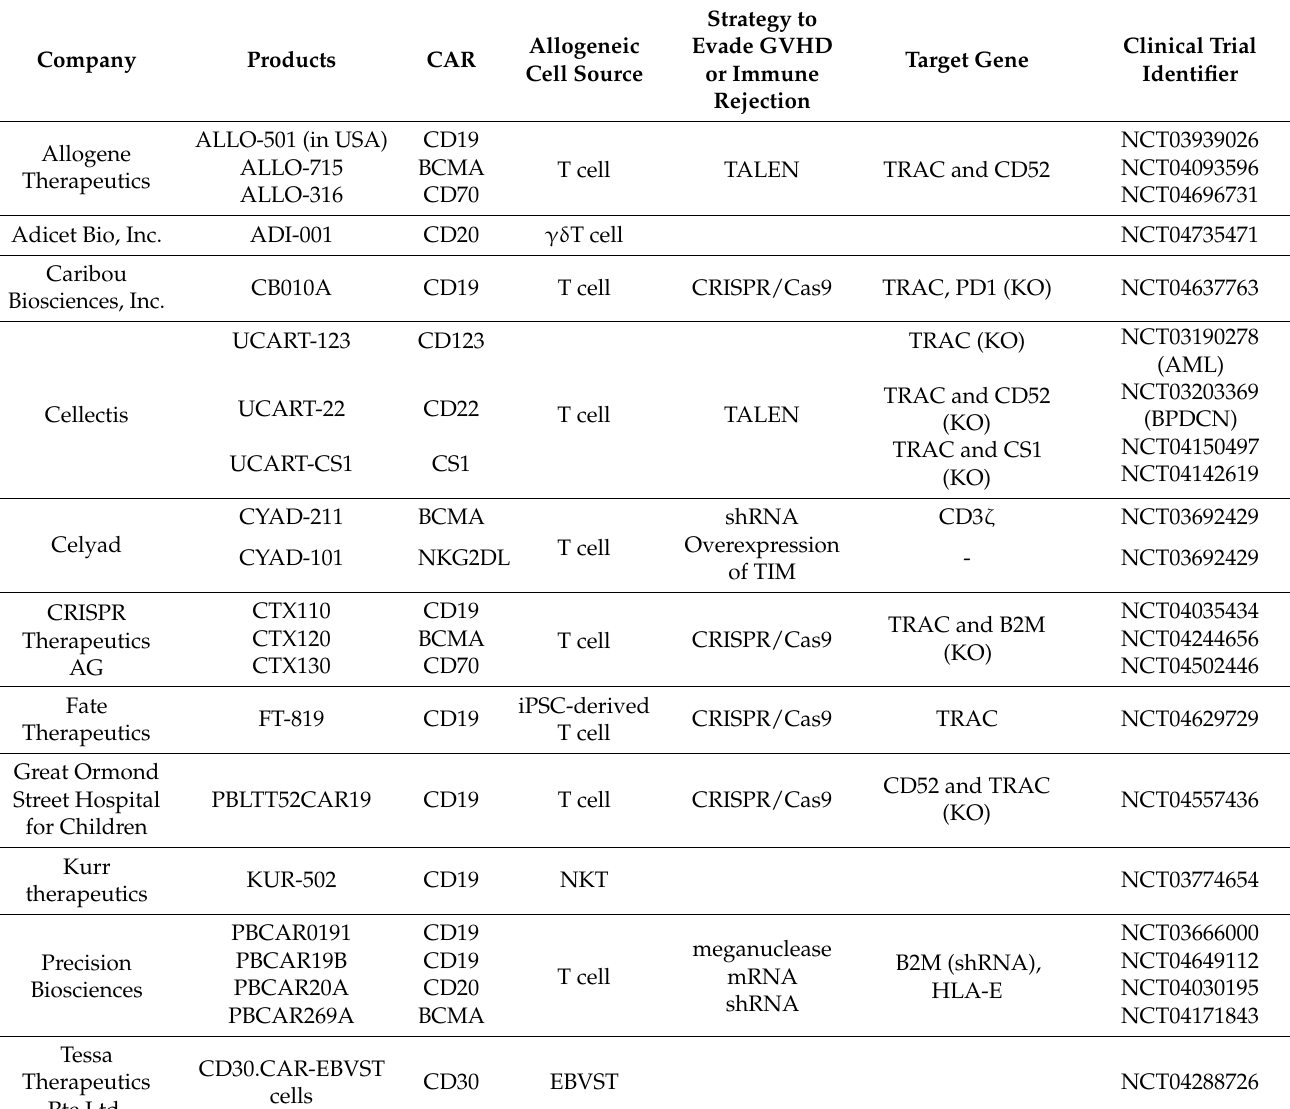
Table 1. Various strategies in allogeneic CART